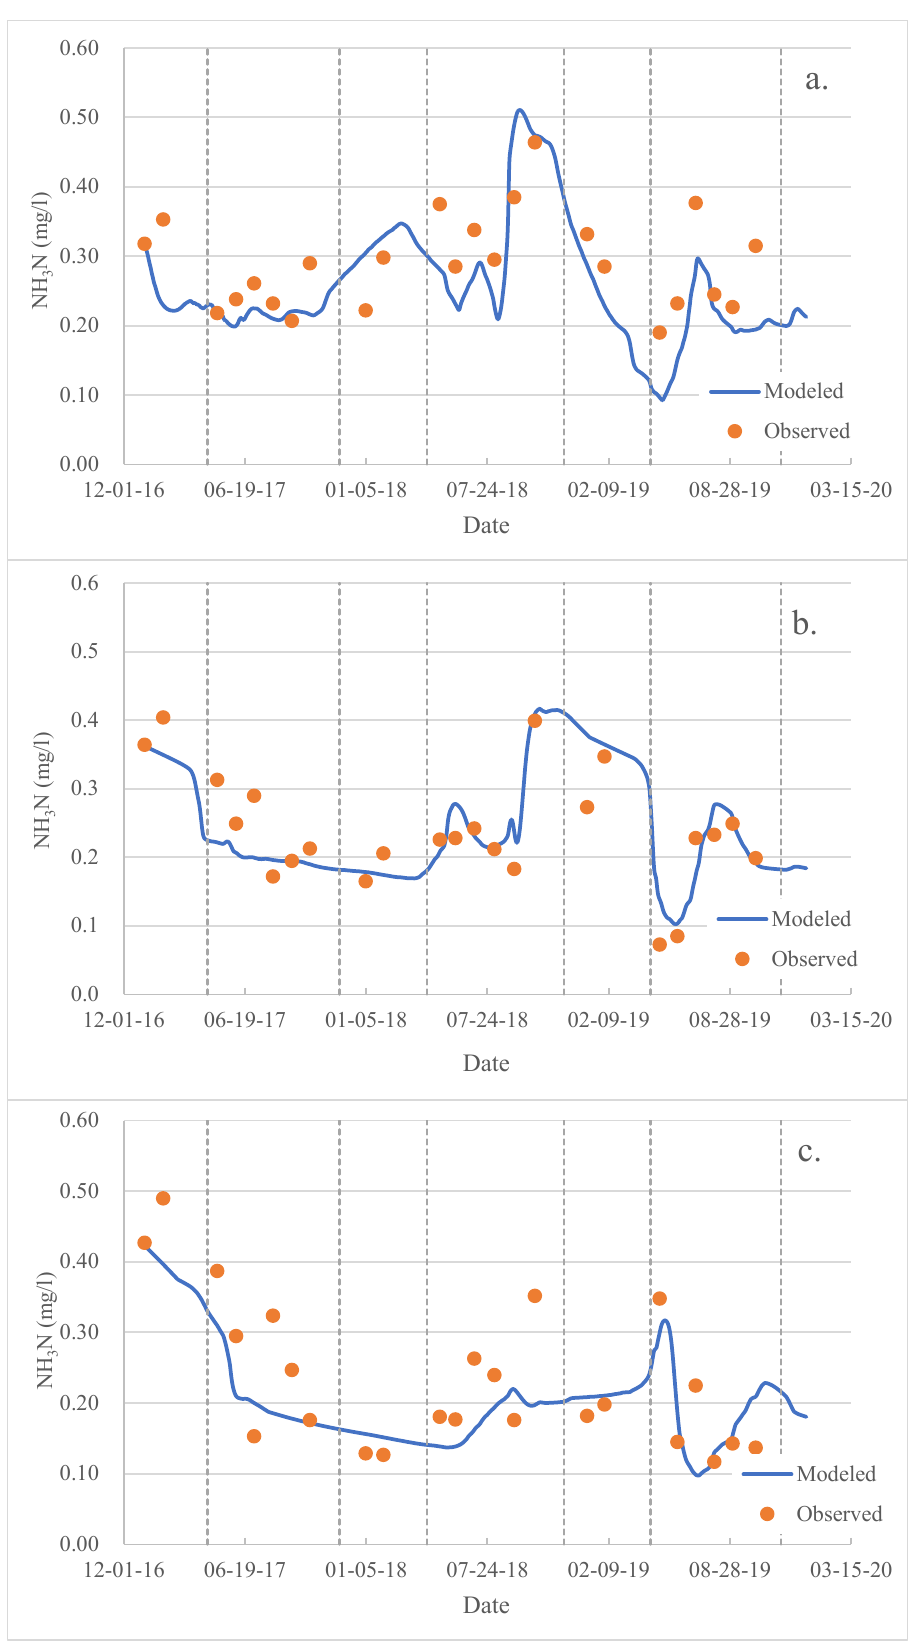
Figure 7. Comparison of the observed and simulated values of NH3N at: ( a ) LHLZ sampling site; Figure 7. Analysis of the correlation between the simulated values and measured values of wa- ( b ) DST sampling site; ( c ) GSC sampling site. ter